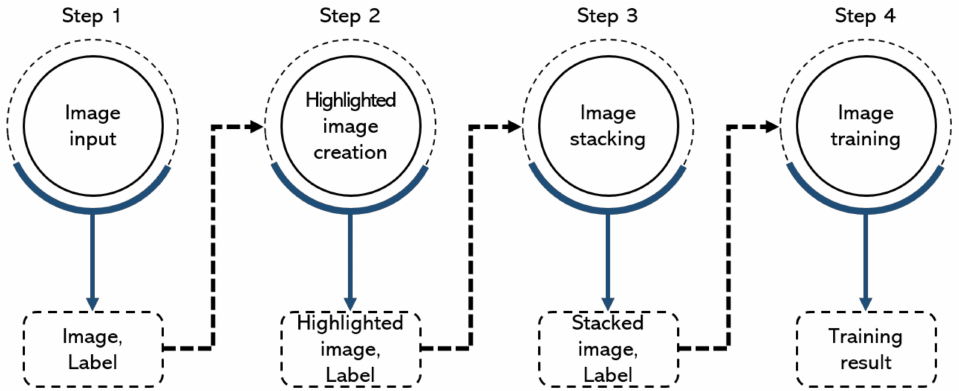
Figure 2. System process.